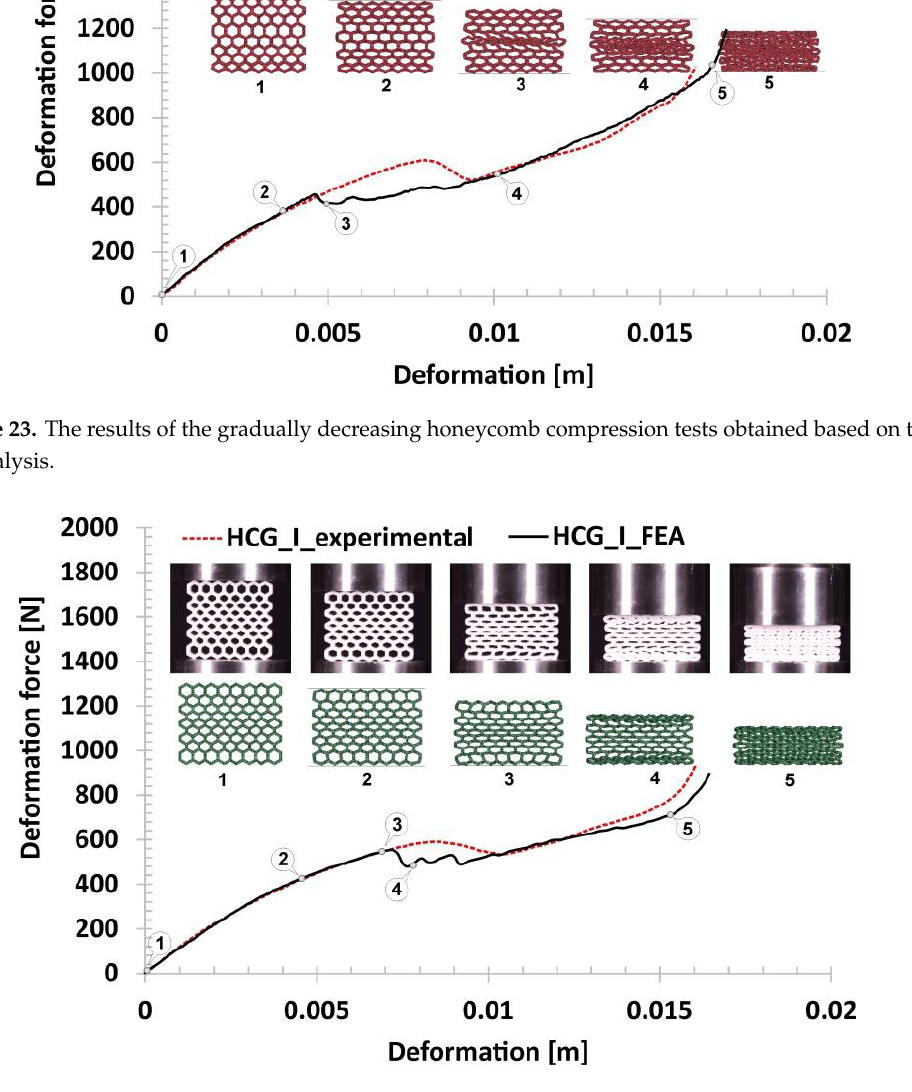
Figure 24. The results of gradually increasing honeycomb compression tests obtained based on the FE analysis.